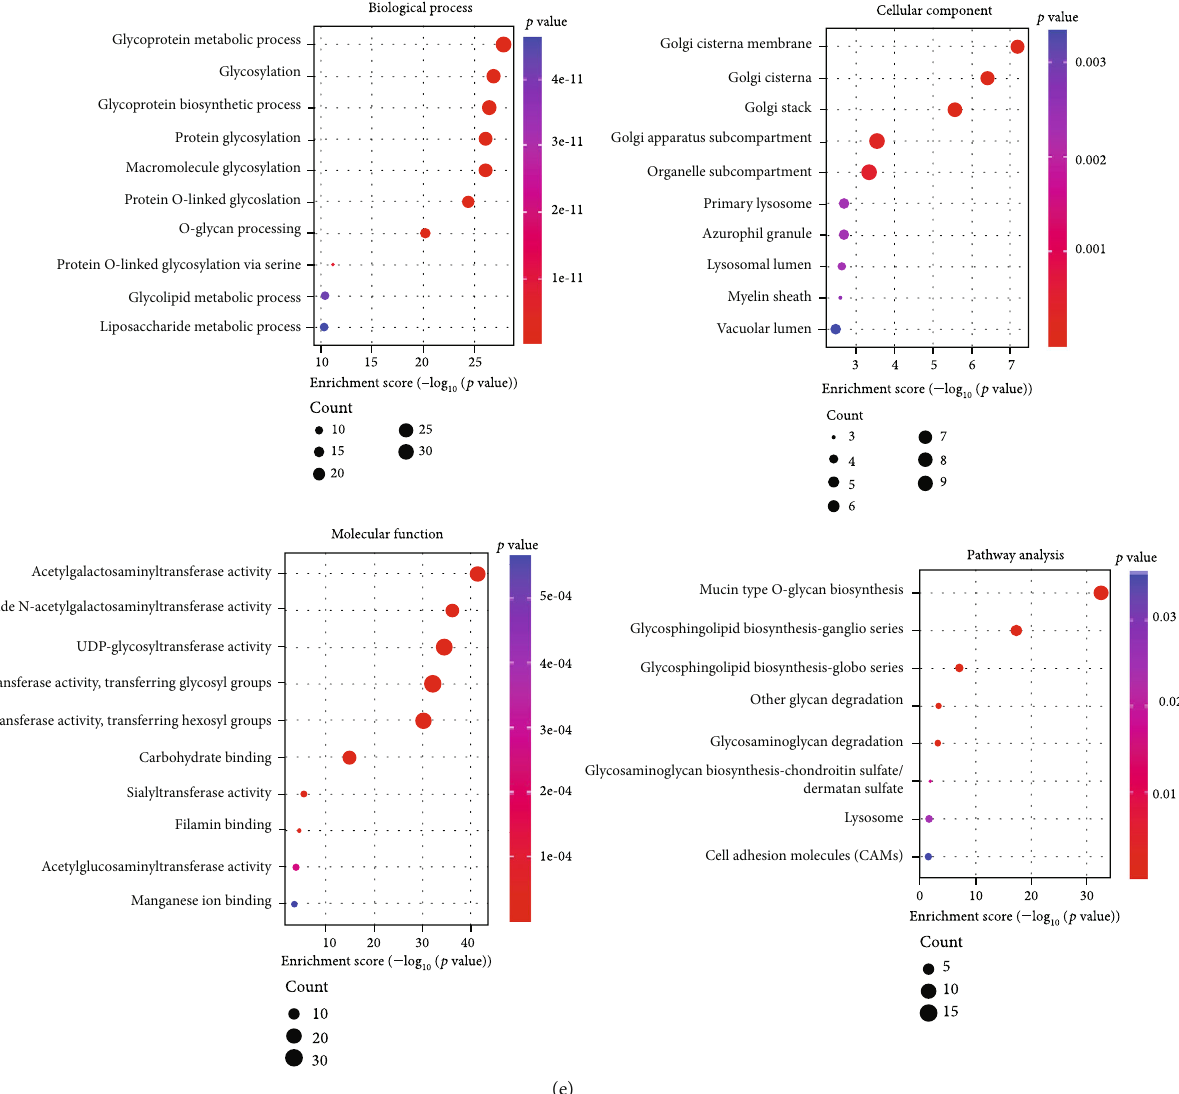
Figure 11: Enrichment analysis of B4GALNT1 expression. (a) An interaction network of 50 B4GALNT1-binding proteins. (b) Correlation between B4GALNT1 expression with ARHGEF25, DCTN2, DTX3, MARCH, and SLC26A10. (c) An intersection of members in (a) and (b). (d) A heat map of correlation between B4GALNT1 expression and the genes in (b). (e) KEGG and GO analyses showed the biological process, cellular component, molecular function, and pathways that were related to